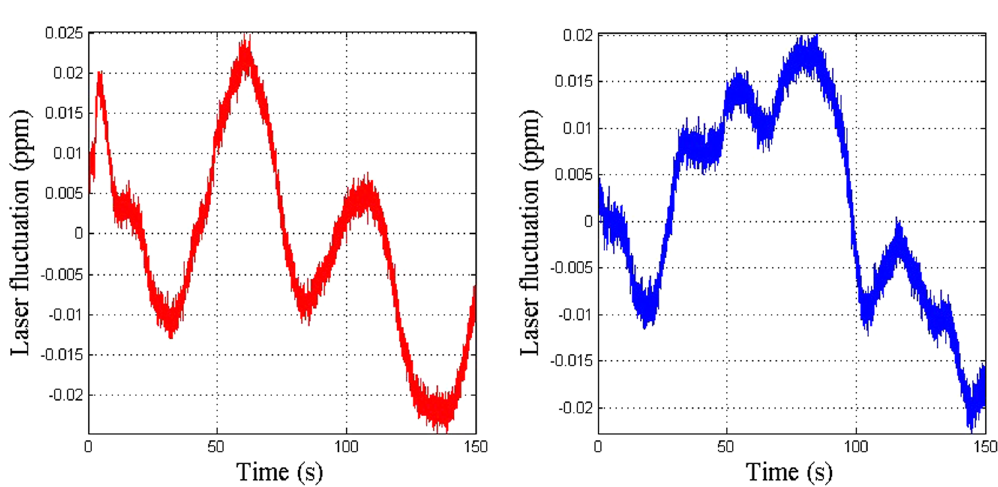
Figure 3. The laser fluctuations: ( a ) the laser fluctuation of the wavelength λ 1 = 0.6328 µ m; ( b ) the laser fluctuation of the wavelength λ 2 = 0.4131 µ